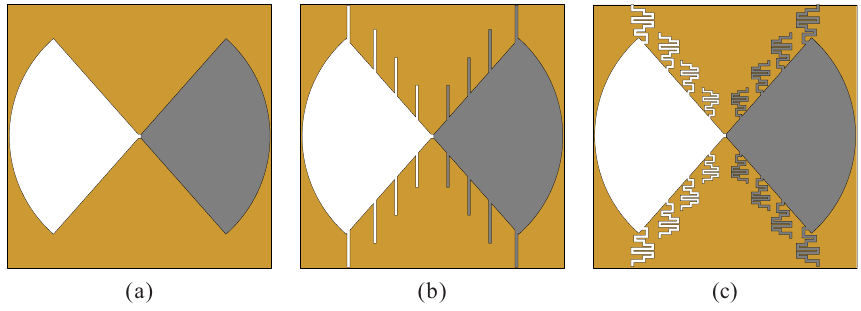
Figure 5. Three types of antennas with AMC: ( a ) reference; ( b ) with strip arms; ( c ) with meandered arms.